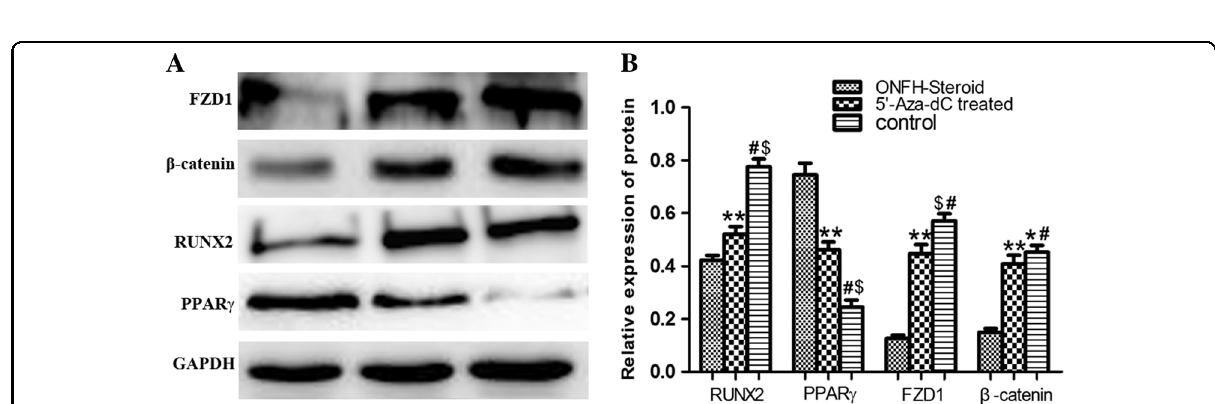
Fig. 4 Western blot. a Western blot analysis of FZD1, β -catenin, Runx2 and PPAR γ . b Gray level analysis of western blot. * P < 0.05 vs. 5 ’ -Aza-dC group. # P < 0.001 vs. ONFH group. $ P < 0.01 vs. 5 ′ -Aza-dC group, 5 ′ -Aza-dC group. ** P < 0.001 vs. ONFH